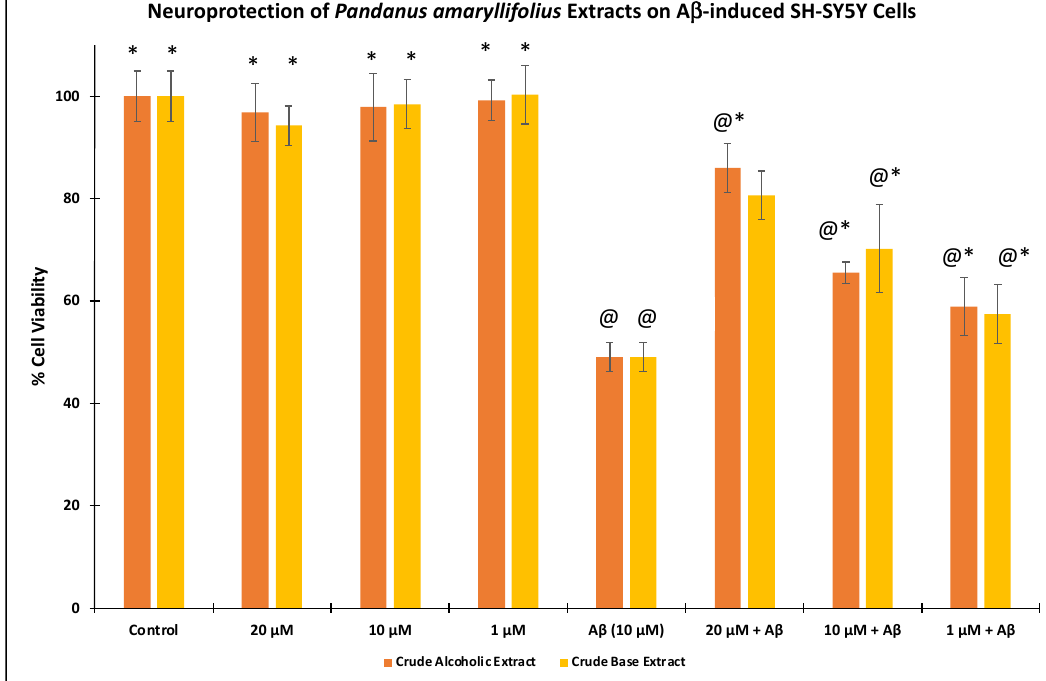
Figure 3. Effect of Pandanus amaryllifolius extracts on neuroprotective activity assay. Neuroblastoma SH-SY5Y cells were treated with the extracts for 6 h, followed by A β (10 μ M) for 24 h. The % cell viability represents mean ± SD (triplicate experiments) and computed based on the control (untreated, 100%). @- statistically significant ( p < 0.05) vs. control; *- statistically significant ( p < 0.05) vs. A β -treated cells.